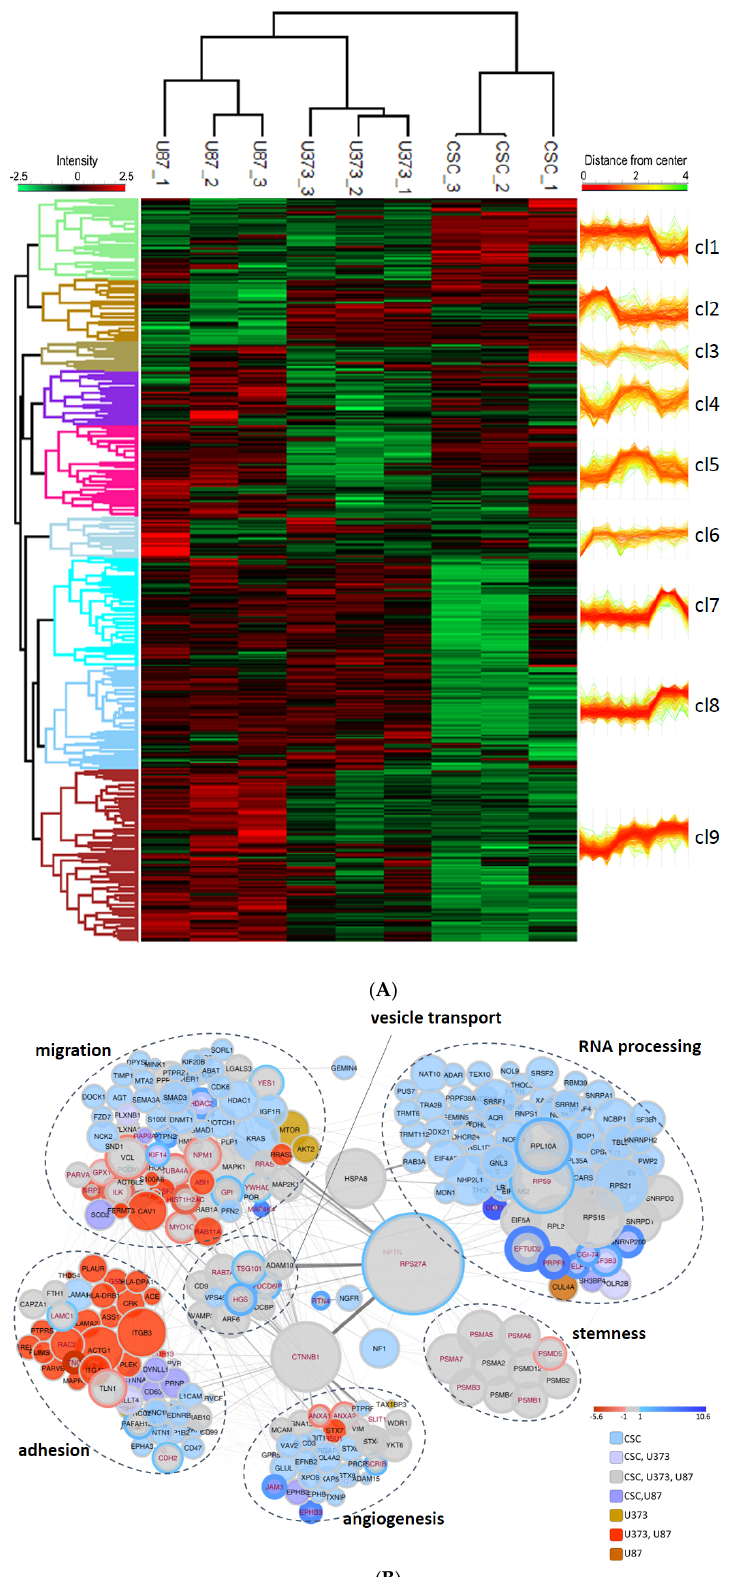
Figure 6. (A ) Hierarchical clustering analysis of proteins in GBM- and CSC-sEVs. The clustering analysis is based on the Euclidean distance and complete linkage. The heatmap was divided into nine clusters (distance threshold = 4.5). ( B ) Functional enrichment analysis of proteins in GBM- and CSC-sEVs. In the String network, the degree of interconnection of each protein is proportional to the node size and the confidence of the interaction to the connecting edge size. The fill color scheme considers the presence of the protein in the samples, while the border color and thickness consider the significant quantitative difference between the CSC sample and established cell line samples (bottom right). The enriched GO Biological function term details are reported in Table S7. Finally, we combined and compared biological processes enriched by miRNA target genes and proteins, to highlight functions that are commonly represented or uniquely carried between GBM- and CSC-sEVs and between miRNA targets and proteins. Interest- ingly, we found that the functions related to cell proliferation, cell death, and stemness are in common between GBM- and CSC-sEVs and are identified by both miRNA targets and proteins found in their sEVs (Figure 7 and Table S8). While the functions of adhesion, migration, and angiogenesis, which we previously found associated with miRNA targets of only GBM-sEVs, resulted enriched also at protein level for both GBM- and CSC-sEVs, the EMT process showed enrichment only for miRNA targets of GBM-sEVs, with no evi- dence of protein involvement. Conversely, the functions related to membrane docking, cell junction organization, and endocytosis were enriched by proteins of both GBM- and CSC-sEVs, with no evidence (if not minimal for endocytosis) of miRNA target involve- ment. Lastly, the ncRNA-processing function was associated only with proteins of CSC- sEVs (Table S8). Notably, the seven proteins described above with RNA-modifying activ- ity regulating gene expression and found expressed exclusively in our CSC-sEVs (ADAR, METTL1, NAT10, PUS7, TRM112, TRM6, and TRMT61A; see Table 3) are included in the ncRNA-processing function (Table S8).